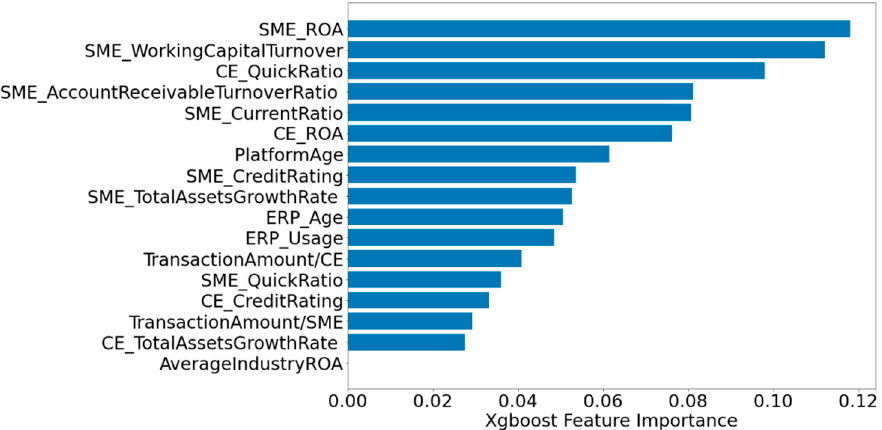
Figure 8. XGBoost feature importance ranking. (Test set = 0.1).